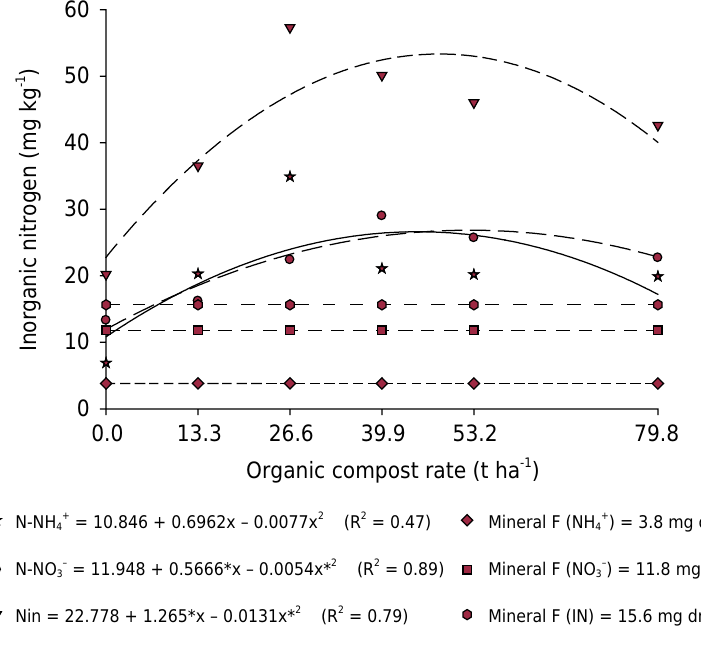
Figure 1. Contents of nitrate, ammonium, and inorganic nitrogen (N-NH 4+ + N-NO 3- ) in response to organic compost and mineral fertilization rates applied to elephant grass in the 0.00-0.20 m layer. *: significant at 5 %